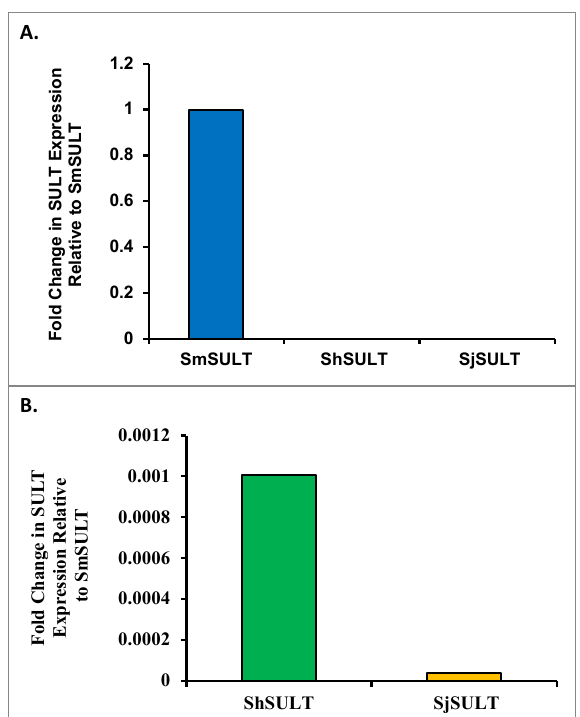
Figure 8. SULT Expression Cross-species Comparison qRT-PCR. Transcripts of the SULT genes from S. mansoni, S. haematobium, and S. japonicum , were evaluated by quantitative reverse transcriptase PCR. Species-specific primers were designed and validated. Relative quantities were determined by an algebraic equivalent to the ∆∆Ct method which allowed adjustment for differences in primer amplification efficiency. ( A ) Transcript levels in all three species relative to S. mansoni . ( B ) Transcript level comparisons between S. haematobium and S. japonicum , with S. mansoni omitted to more clearly show the difference between ShSULT and SjSULT . 3.5. SULT Transcripts: S. mansoni vs. S. haematobium vs. S. japonicum ddPCR. Droplet digital PCR (ddPCR) was used to obtain absolute quantities of SULT transcripts, rather than relative quantities, in S. mansoni mature adult worms compared to S. haematobium and S. japonicum mature adult worms. Concentrations of sulfotransferase enzyme expression were obtained for all three species; S. mansoni (610 copies/µL), S. haematobium (45.8 copies/µL), and S. japonicum (1.5 copies/µL) (Figure 9A). The difference between S. haematobium and S. japonicum is further highlighted in Figure 9B. Based on these data, there is about a 13-fold difference in expression between S. mansoni and S. haematobium (Figure 9A), and a 30-fold difference in expression between S. haematobium